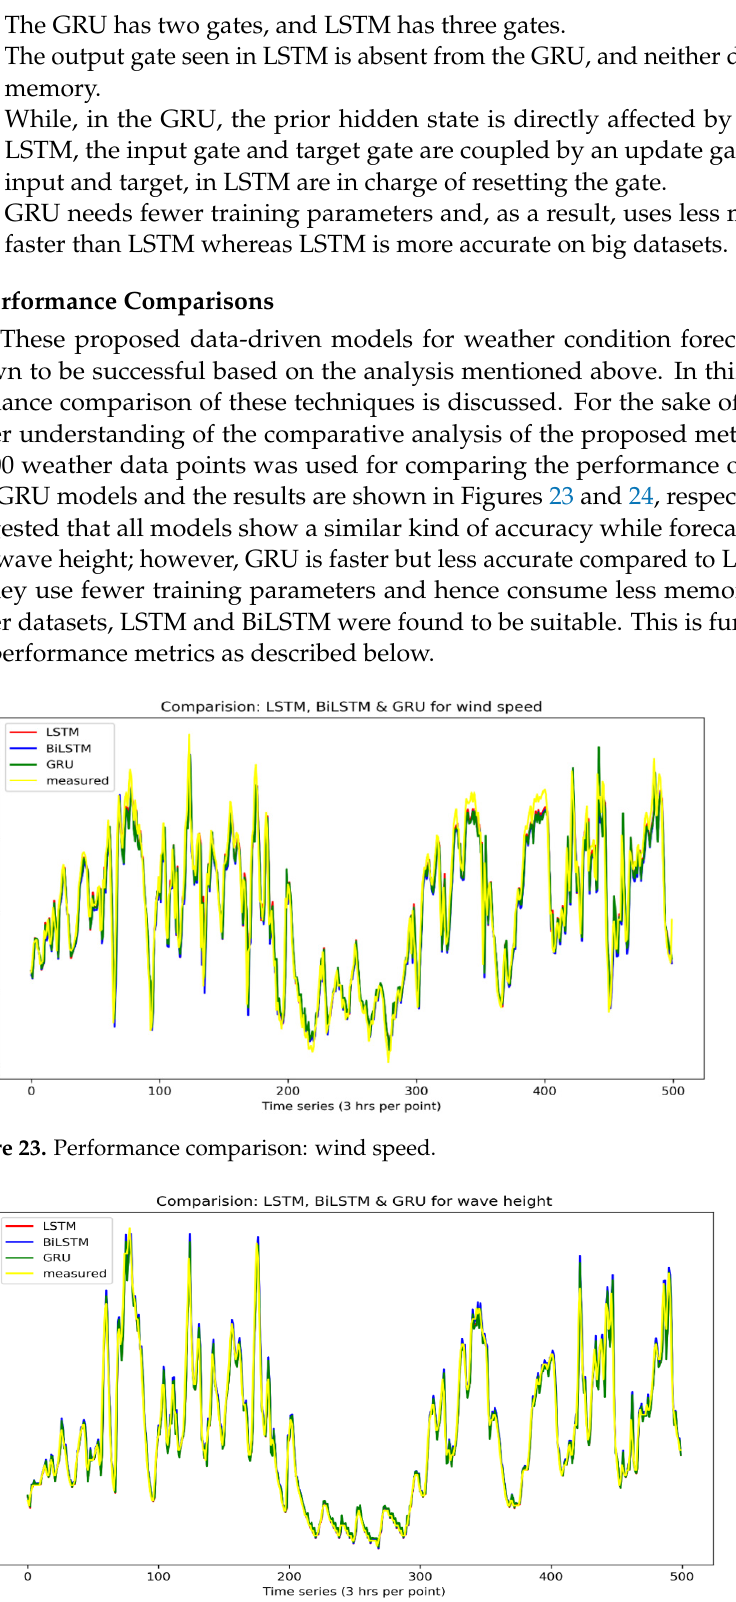
Figure 24. Performance comparison: wave height.